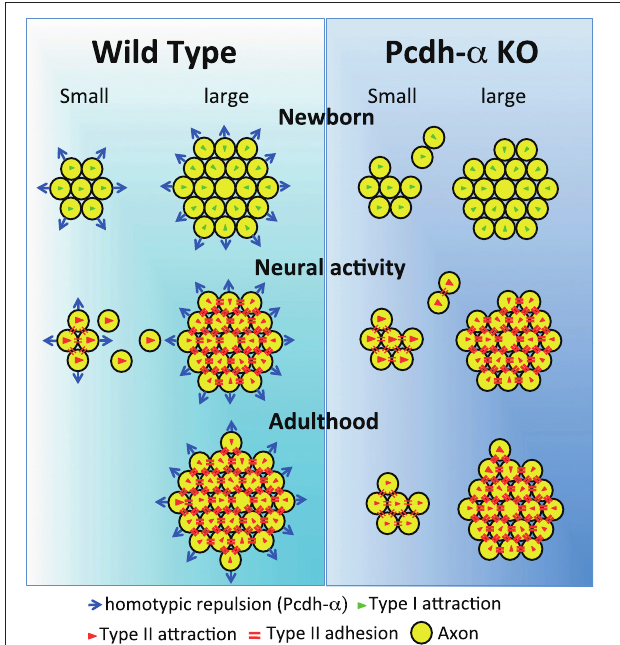
FIGURE 10 | Possible mechanism for the coalescence and elimination of homotypic OSN projections mediated by Pcdh- α proteins. In newborn mice, homotypic OSN axons coalesce by Type I attraction (green triangles). Type I attraction is performed by axon-target interaction by guidance molecules in a graded manner, e.g., Sama3A/Neuropilin1. Pcdh- α protein may elicit a contact-induced repulsion between homotypic OSN axons. In Pcdh- α -deficient mice, small glomeruli were generated because the contact-induced repulsive activity did not occur. During development, neural activity promotes Type II attraction (red triangles) and the Type II adhesion (red double-bars) of homotypic OSN projections. Type II attraction depends on axon-axon interactions during contact-induced repulsion between heterotypic OSN axons, e.g., mediated by EphA5/ephrin-A5. Type II adhesion results from the induction of expression of homophilic cell adhesion molecules, e.g., Kirrel2/Kirrel3. In small ectopic glomeruli, these attractive functions promote the correct coalescence of homotypic OSN projections and the elimination of ectopic projections. Pcdh- α protein may help to eliminate small ectopic glomeruli by the contact-induced repulsion of homotypic OSN axons. In adulthood, multiple small ectopic glomeruli disappear in WT mice, but are maintained in Pcdh- α -deficient mice. The interdependence of OSN coalescence could result from the balance between the neural-activity-induced attraction by guidance molecules and